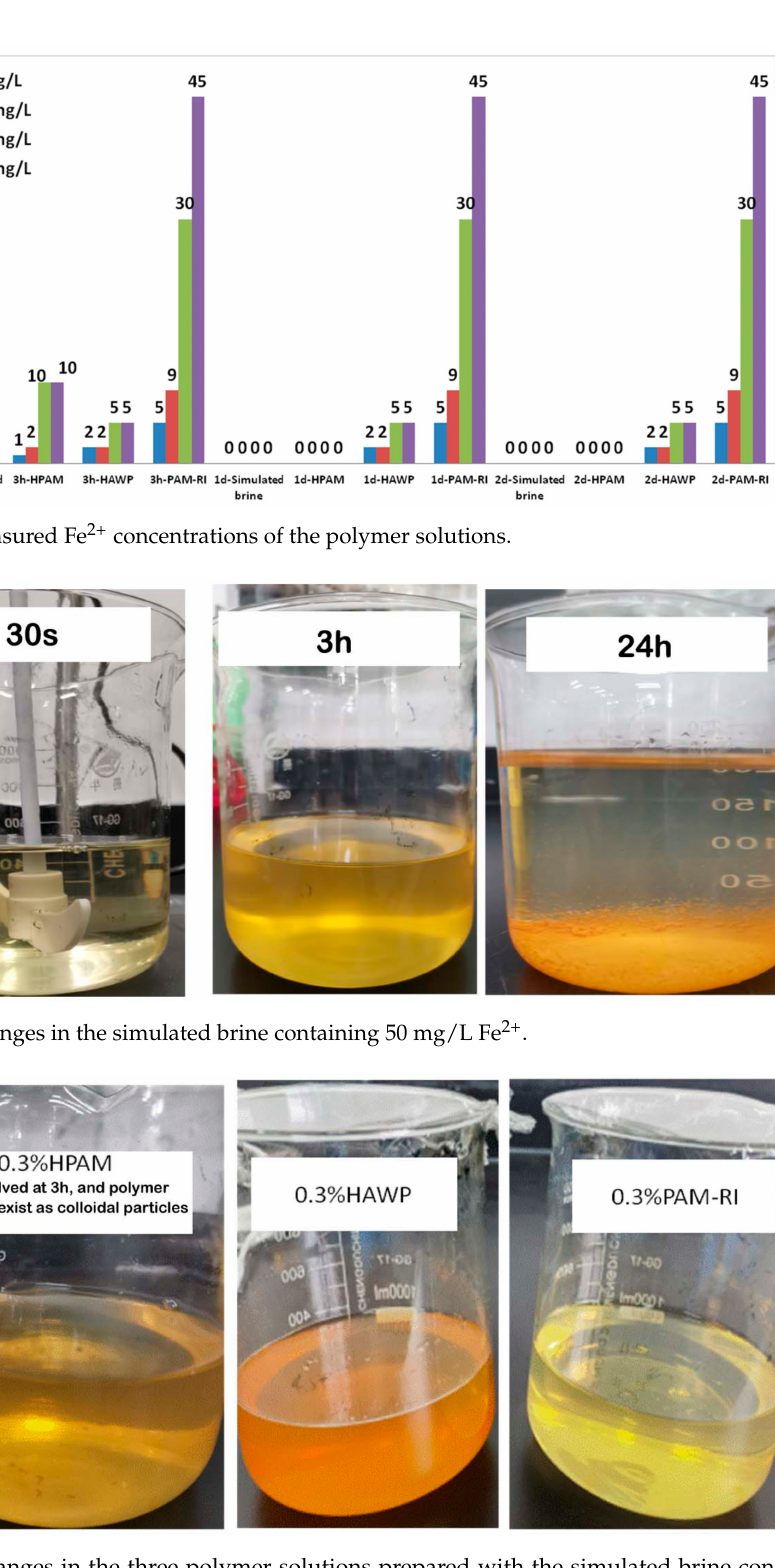
Figure 8. Changes in the three polymer solutions prepared with the simulated brine containing 50 mg/L Fe 2+ at 3